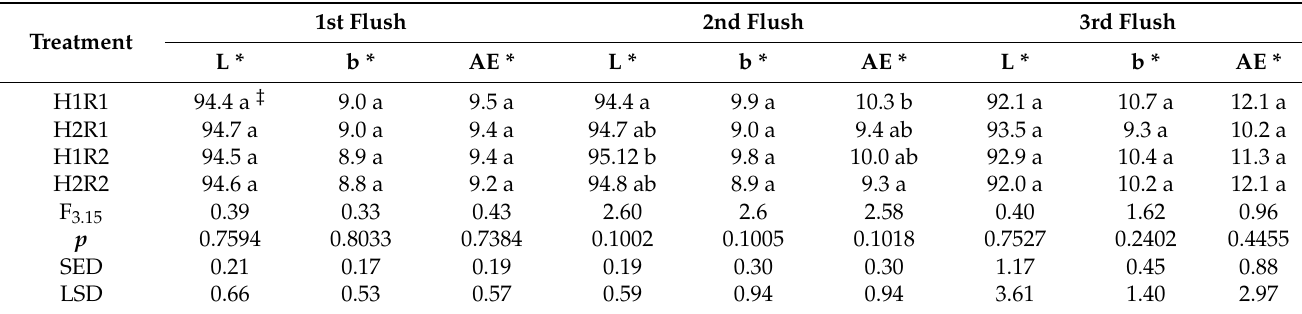
Table 3. Colour as qualitative parameter of the basidiomes harvested in the three flushes for the treatments set up in trial A.